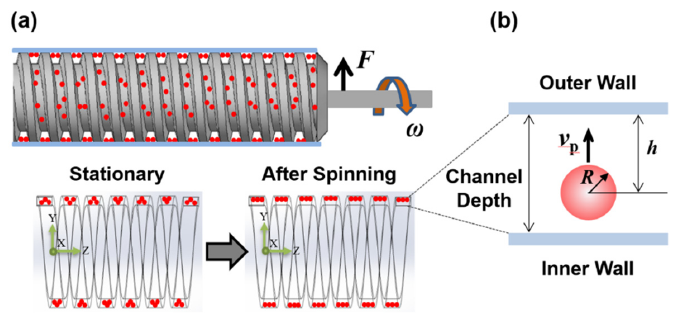
Figure 3. ( a ) Schematic of particle confinement in a helical minichannel after spinning the sample cartridge; ( b ) schematic of a particle moving toward the outer wall during spinning.